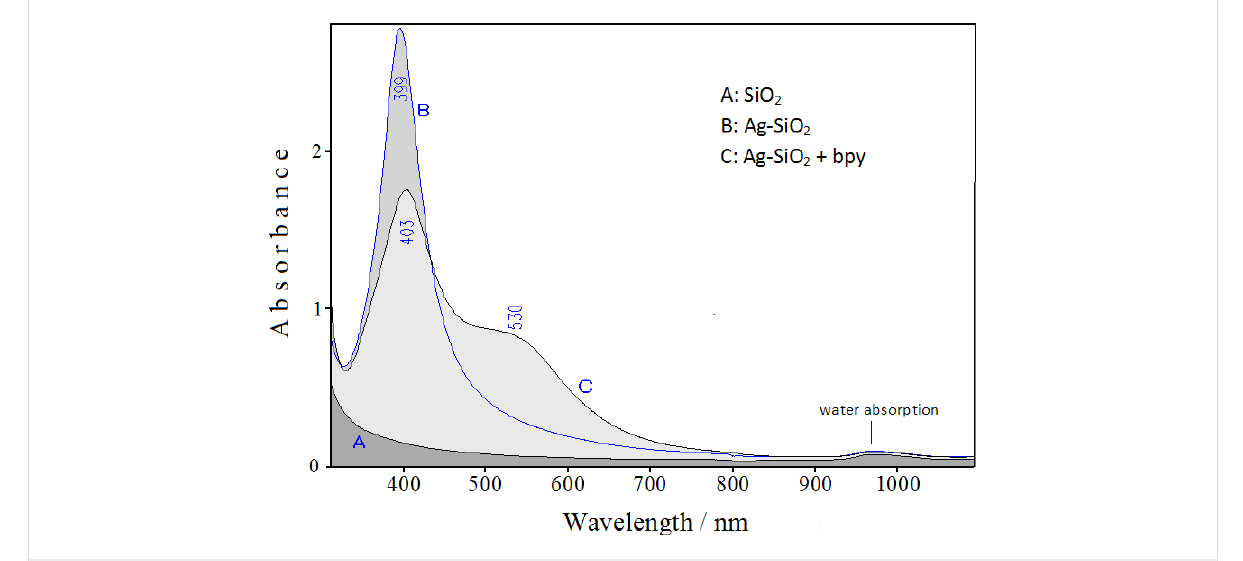
Figure 1: UV–visible absorption spectra of colloidal silica (A) and Ag-doped silica suspension before (B) and after addition of bpy